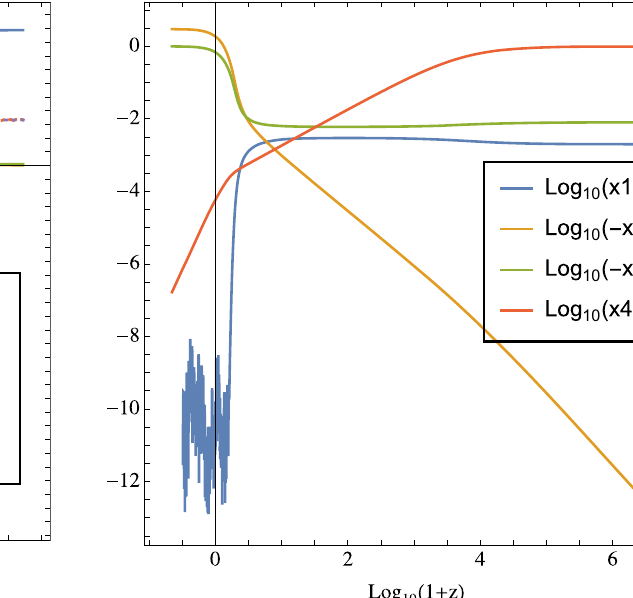
Fig. 2 The evolution of the dynamical parameters where the initial conditions are the same as the Fig.